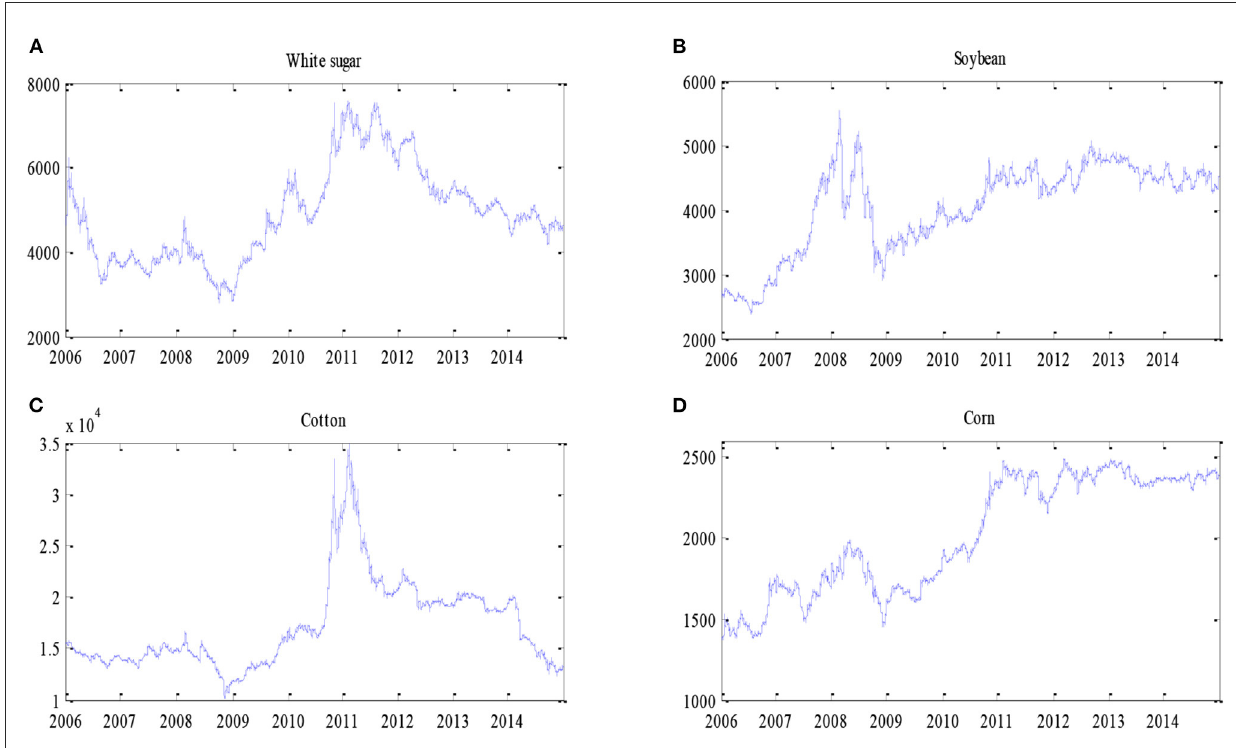
FIGURE1 White sugar (A) , soybean (B) , cotton (C) , and corn (D) futures prices at 5 min frequency.